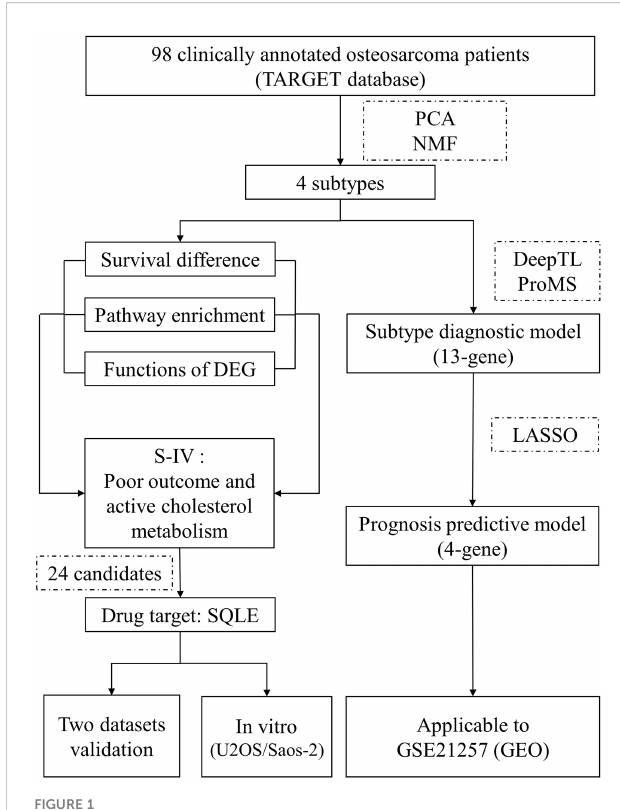
FIGURE 1 Outline of the study design. A dataset containing gene expression data from 98 osteosarcoma patients and relevant clinical information was utilized for molecular classi fi cation and subtype characterization. Features of subtype IV were mined to identify a drug target that ful fi lled the “ targeting cholesterol biosynthesis for living longer ” implication. The screening yielded 24 candidates, of which only SQLE was encoded for a therapeutically actionable option. This drug target was tested in two independent cohorts and in vitro experiments. Moreover, we employed two machine learning tools to develop a 13- gene model to determine the subtype of osteosarcoma patients. Based on the 13 curated genes, we used the LASSO method to establish a 4-gene model to recognize patients with a signi fi cant unfavored outcome. These two models were both well evaluated by an independent dataset. TARGET, Therapeutically Applicable Research to Generate Effective Treatments; PCA, principal component analysis; NMF, non-negative matrix factorization; DEG, differentially expressed genes; S-IV, subtype IV; LASSO, least absolute shrinkage and selection operator; GEO, Gene Expression